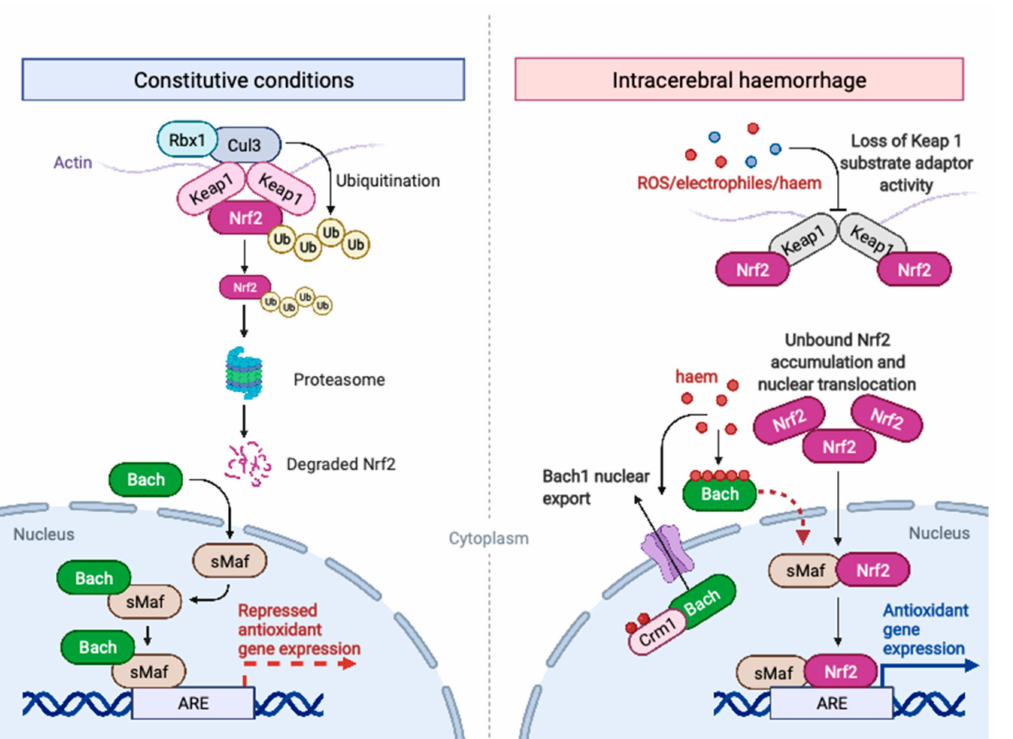
Figure 3. Regulation of Nrf2 activation in constitutive conditions and after ICH. Under constitu- tive conditions, Nrf2 is anchored to cytoplasmic actin by Kelch-like ECH-associated protein 1 (Keap1) homodimers. These also function as adaptor proteins for Cullin 3 (Cul3)-dependent E3 ubiquitin ligase complex RING box protein 1 (Rbx1) which ubiquitinates Nrf2, leading to its proteasomal degra- dation. BTB and CNC homology (Bach) proteins bind nuclear small Maf (sMaf) protein and repress expression of certain antioxidant genes. During conditions of oxidative stress or haem accumulation, as may occur after ICH, Keap1 loses its’ substrate adaptor activity and becomes saturated with Nrf2. Nrf2 levels rise and Nrf2 localises to the nucleus where it heterodimerises with sMaf proteins to transactivate genes containing an antioxidant response element (ARE) motif. Simultaneously, haem binding of Bach proteins prevents heterodimer formation with sMaf proteins and induces nuclear export of Bach by chromosomal maintenance 1 (Crm1). Created with